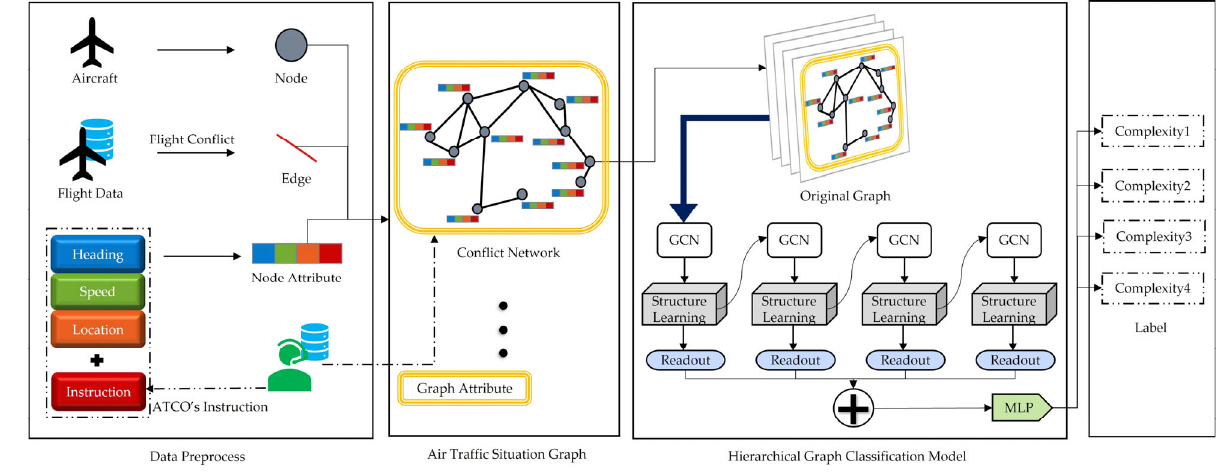
Figure 1. HGRL architecture for sector complexity evaluation.